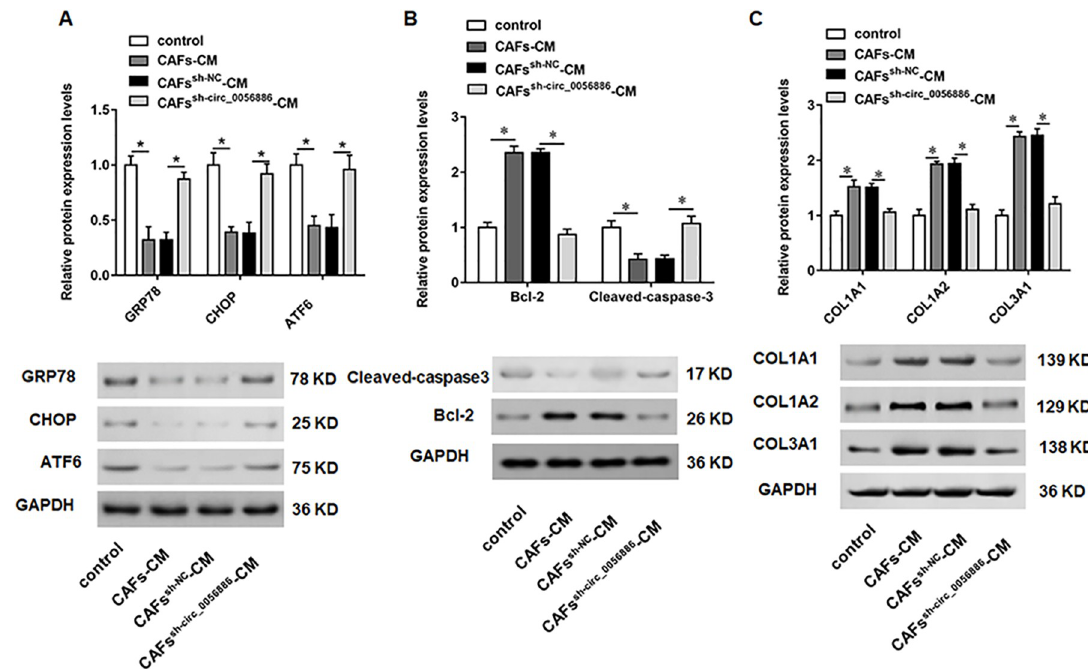
Fig 4. Effect of knockdown of hsa_circ_0056686 in CAFs on ERS and ECM. LSMCs were treated with CAFs-CM or CAFs sh- circ_0056686 -CM. (A) The expression of ERS-related proteins GRP78, CHOP and ATF6 was examined. (B) The expression of apoptosis- related proteins Cleaved-caspase3 and Bcl-2 was examined. (C) The expression of ECM-related proteins COL1A1, COL1A2 and COL3A1 was examined. � P < 0.05, vs control or CAFs sh-NC -CM.